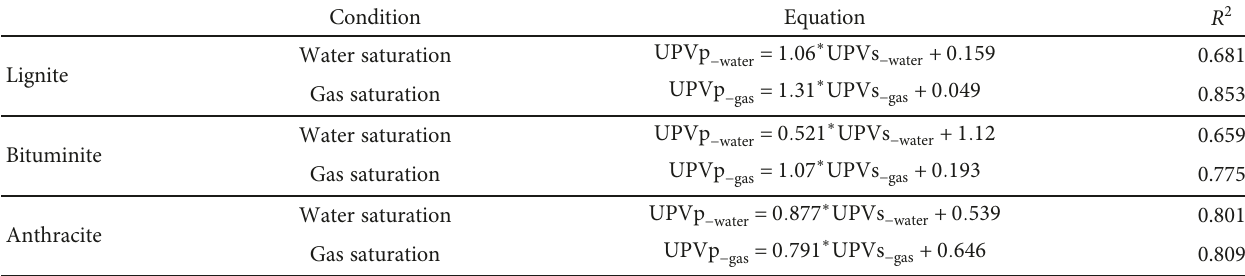
Table 3: Correlations between UPVp and UPVs for lignite, bituminite, and anthracite under water or gas